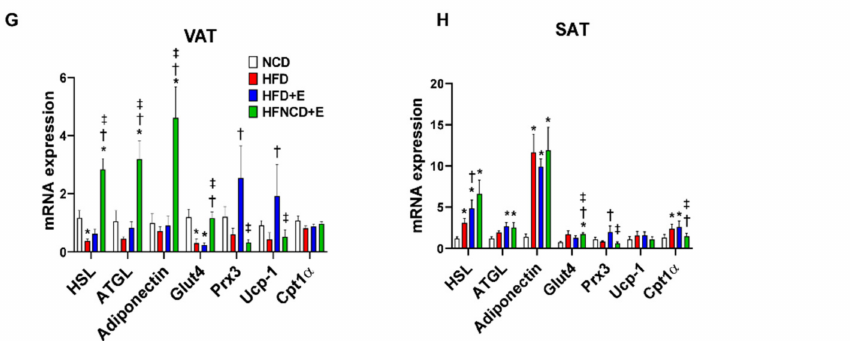
Figure 2. Exercise and diet ameliorate metabolic dysregulation in HFD-induced obese mice. ( A ) Oral glucose tolerance test (OGTT) and ( C ) intraperitoneal insulin tolerance test (IPITT) were performed at week 8 of the exercise training program. Blood glucose levels were measured at 0, 30, 60, 120, and 180 min, and the AUC was determined. For IPITT, inverse AUC was also calculated, correcting for baseline glucose levels. ( B ) Plasma insulin, ( D ) free fatty acid, ( E ) triglyceride, and ( F ) adiponectin levels were measured by ELISA in 20-week-old mice sacrificed in fed state, 24 h after the end of the exercise program. Plasma adiponectin levels (left panel in F) were adjusted by adipose tissue weight (right panel). ( G , H ) Metabolic gene expression was measured in visceral and subcutaneous adipose tissues via real-time PCR. The quantifications were normalized to the 18S rRNA level for each target. Values are presented as mean ± SEM. * p < 0.05 compared with NCD, † p < 0.05 compared with HFD, ‡ p < 0.05 compared with